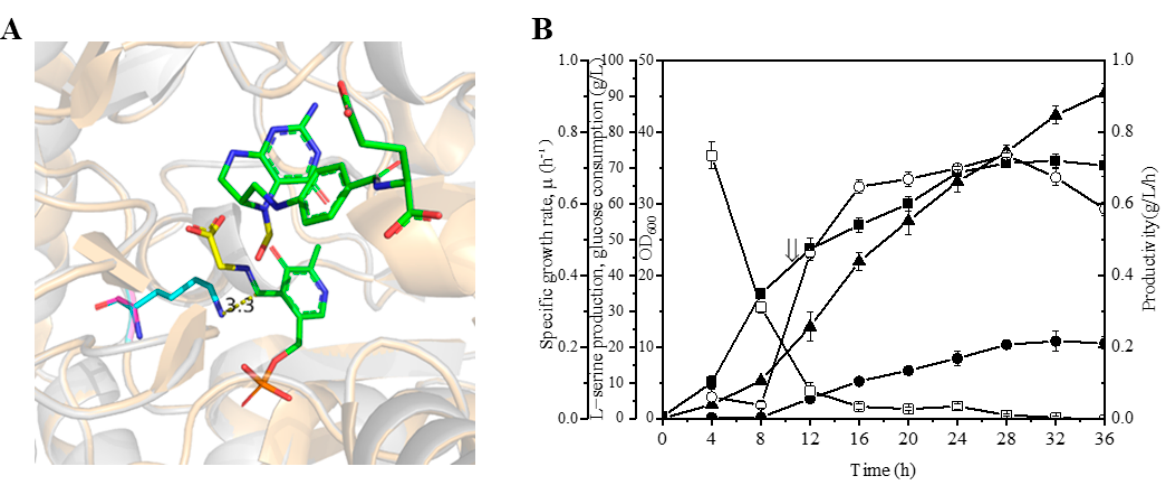
Figure 3. SSW-03/SP-08 L-serine production during fed-batch fermentation. ( A ) Structural modelling of SHMT mutant K229G (light gray) and comparison with the wild-type (light orange, PDB ID, 1DFO) in cartoon format. The cofactor PLP and THFA are shown as sticks in green. The L-serine degradation products glycine and formyl group are the sticks in yellow. K229 of the wild-type is shown in cyan and G229 of the mutant is in magenta. The O is in red and the N is in blue. ( B ) SSW- 03/SP-08 L-serine production by fed-batch fermentation. Cell growth (filled squares), L-serine con- centration (filled circles), glucose consumption (upward-pointing filled triangles), specific growth